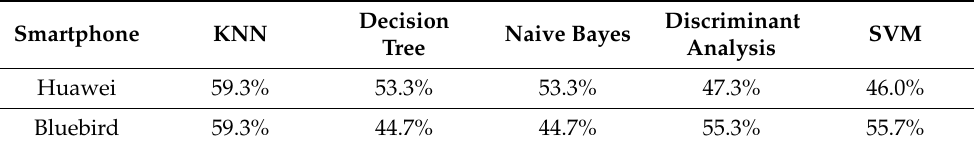
Table 6. Accuracy comparison of heterogeneous devices with different positioning methods. (iPhone Xs Max is the training set; Huawei P9 and Bluebird are the test sets, respectively). Smartphone